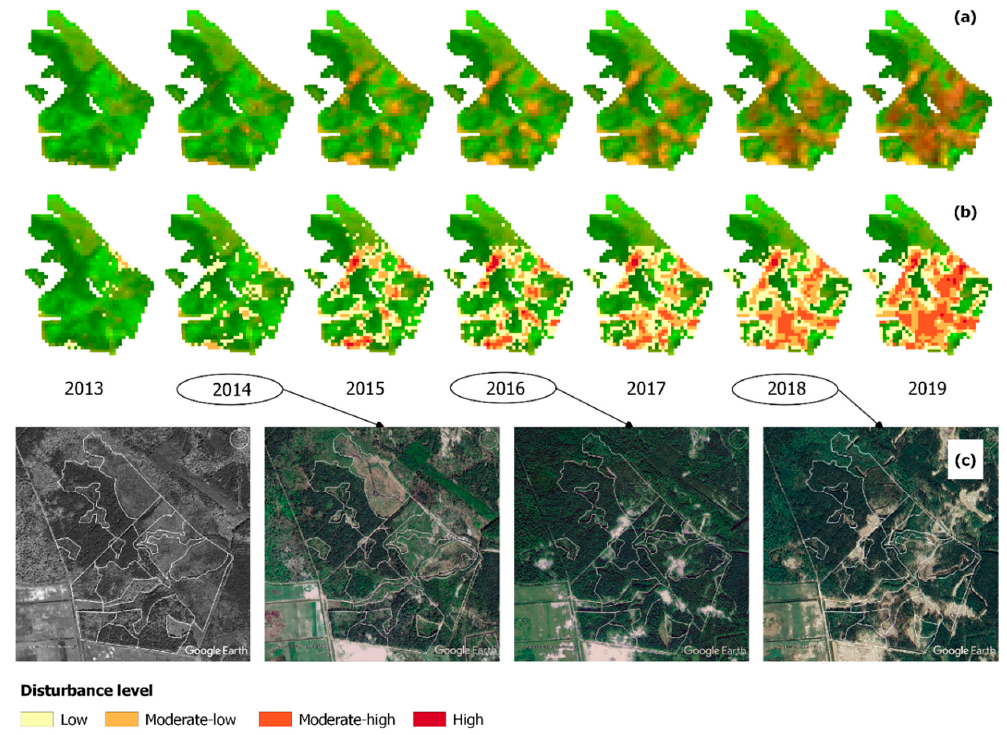
Figure 3. An example showing illegal amber disturbance rates depicted over one AOI in the Dubrovytsia FMU in the Rivne region (the onset of disturbance is 2012): ( a ) yearly LandTrendr-fitted LTS in the band combination SWIR 1–Near infrared (NIR)–Red; ( b ) disturbance levels placed on the LTS; and ( c ) available GE image with forest polygons overlaid to provide a close look at the forest disturbances (the date of the panchromatic image on the left is 2011).